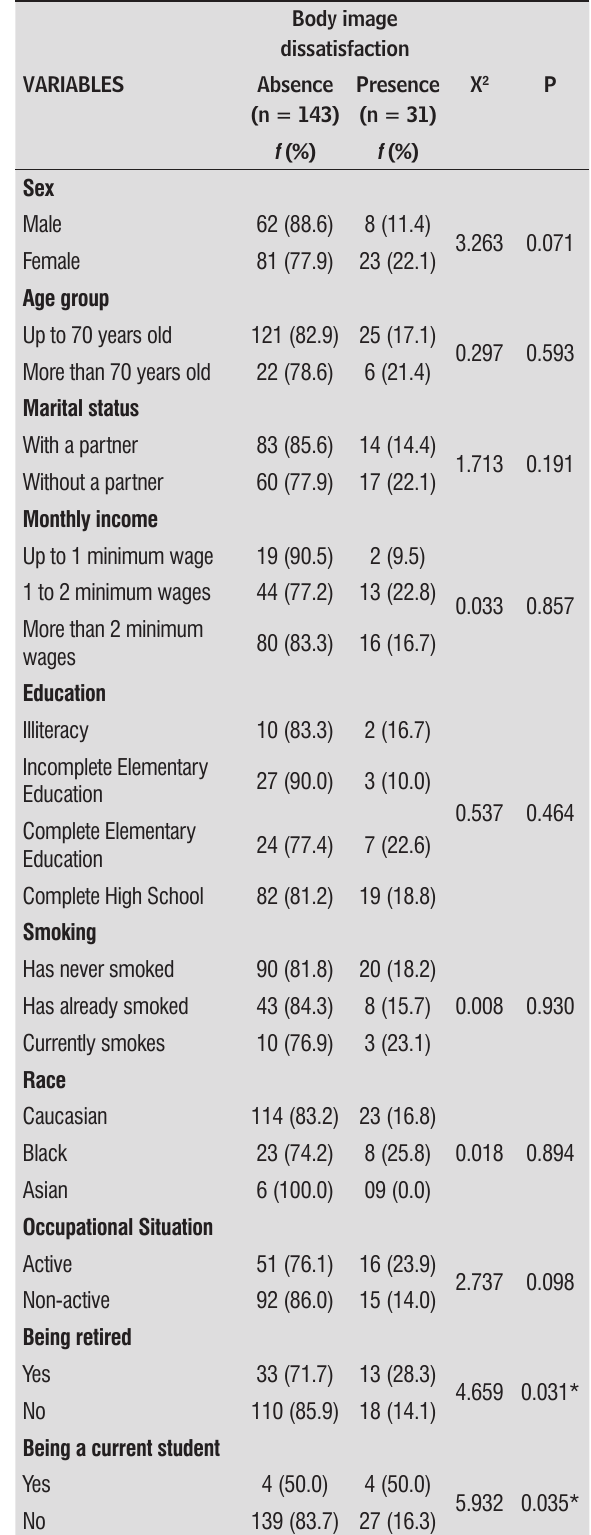
Table 3 - Association of body image dissatisfaction with the sociodemografic variables of the elderly who practice weight training in Maringá -